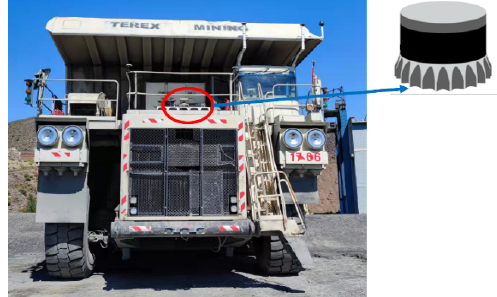
Figure 8. Truck equipped with an ouster OS1-64 LiDAR.